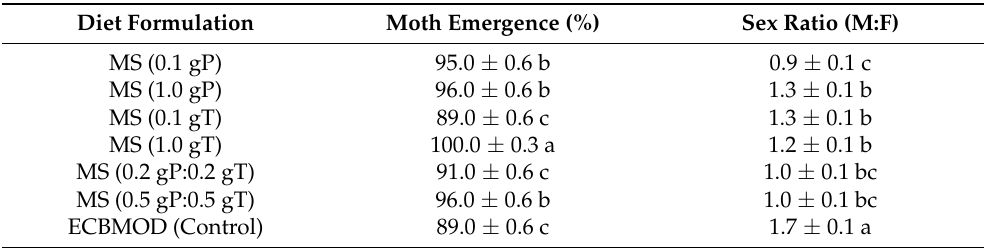
Table 7. Mean ( ± SE) emergence and sex ratio (Male: Female) of Eldana saccharina moths [ n = 130] from pupae harvested from the MS (0.1 gP), MS (1.0 gP), MS (0.1 gT), MS (1.0 gT), MS (0.2 gP:0.2 gT), MS (0.5 gP:0.5 gT) and ECBMOD control diets. Means within columns with different lower-case letters indicate significant differences ( p <